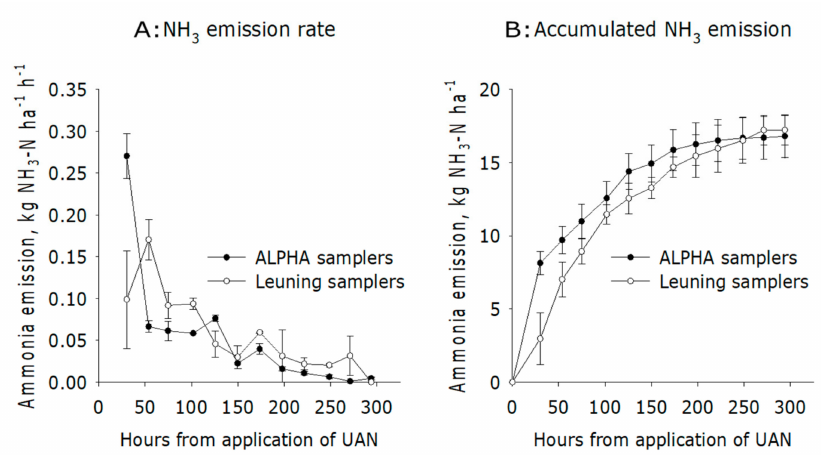
Figure 4. Test of the measuring technique in August, where the rate of NH 3 emission from a urea ammonium nitrate (UAN)-treated plot was measured with passive flux samplers (Leuning samplers) and passive concentration samplers (ALPHA samplers). A: NH 3 emission rate. B: cumulative NH 3 emission (Error bars: SE, n = 3).